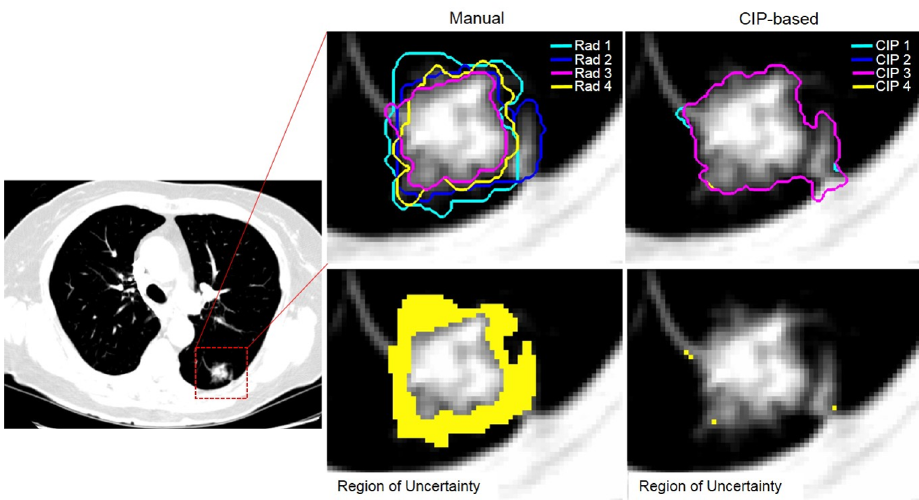
Fig 1. Comparison of manual (left) and CIP-based (right) segmentation. Yellowshaded regionindicated the disagreement (or regionof uncertainty) betweencontours performed by four radiologists (bottom left) or different CIP-basedseed locations(bottom right). In this example,the regionof uncertainty for manual segmentation was 3222 ml whilethe regionwas only 46 ml for the CIP-basedsegmentation. dsi CIP was (cid:25) 100%, while dsi manual was 88%.